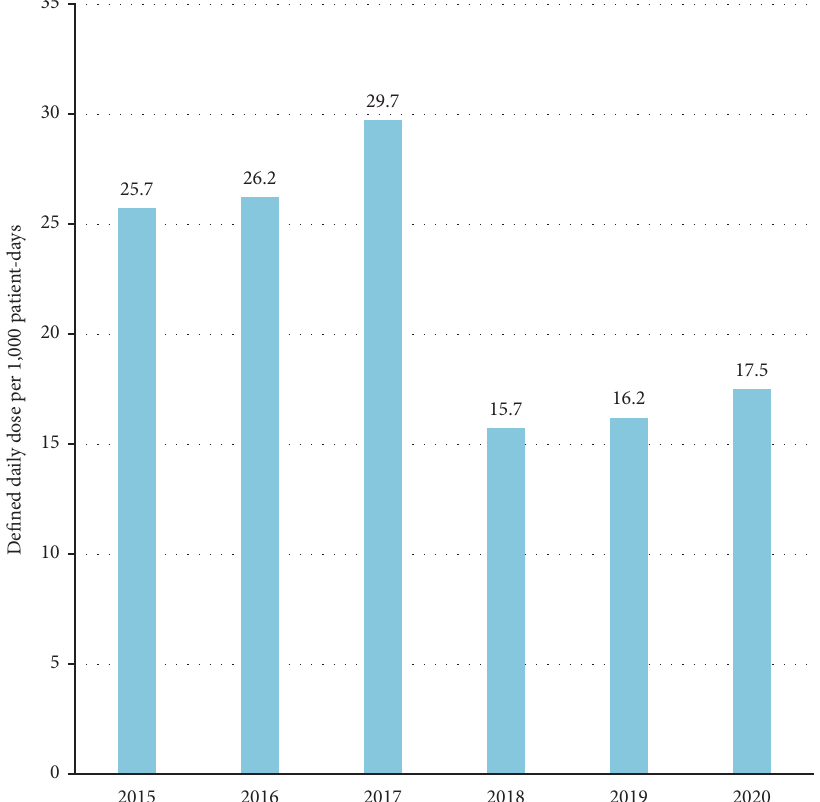
Figure 4: Change is defined as daily doses of restricted antimicrobials per 1,000 patient days following the implementation of the an- timicrobial stewardship